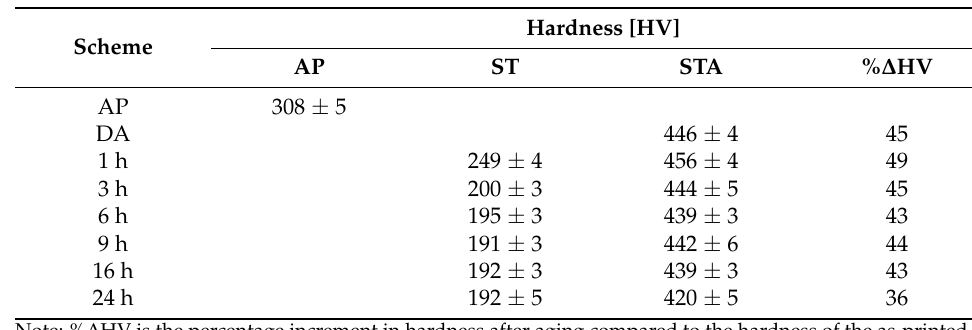
Table 3. Average hardness (HV) of as-printed, direct-aged, ST and STA samples.